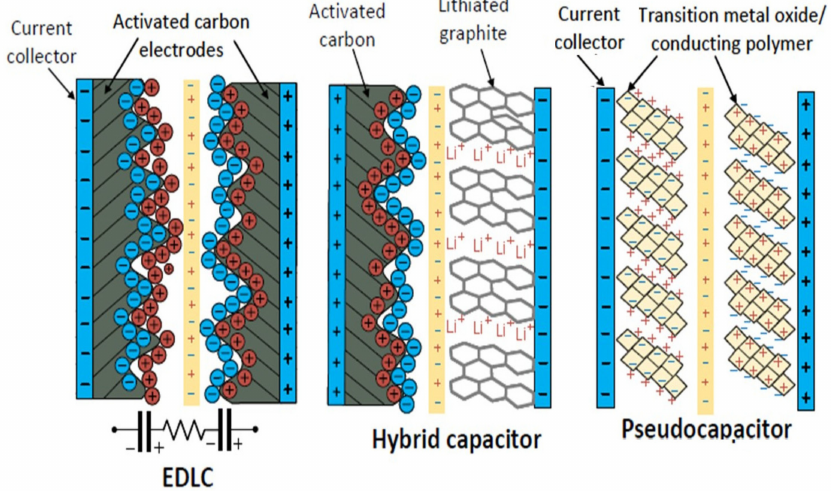
Figure 1. Comparison of three commercial SC families—symmetrical, hybrid, and pseudocapaci- tor